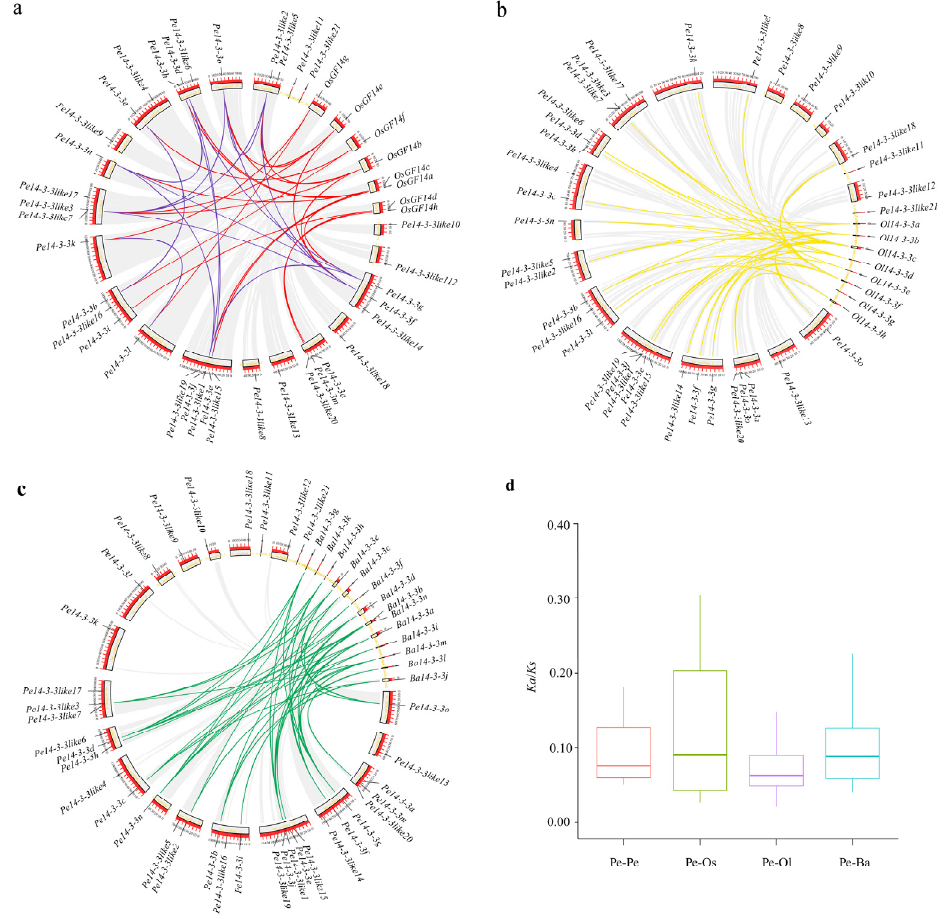
Figure 2. Collinearity of 14-3-3 genes in P. edulis and four other plants (Ba: B. amplexicaulis ; Ol: O . latifolia ; Os: O . sativa ; Pe. P . edulis ). ( a ) Collinearity among Pe14-3-3 s (blue lines) and that between Pe14-3-3 s and Os14-3-3 s (red lines). ( b ) Collinearity of Pe14-3-3 s and Ol14-3-3 s (yellow lines). ( c ) Collinearity of Pe14-3-3 s and Ba14-3-3 s (green lines). ( d ) Boxplot statistics of Ka / Ks values of the 14-3-3 orthologous gene pairs within P. edulis and those between P. edulis and other three species.